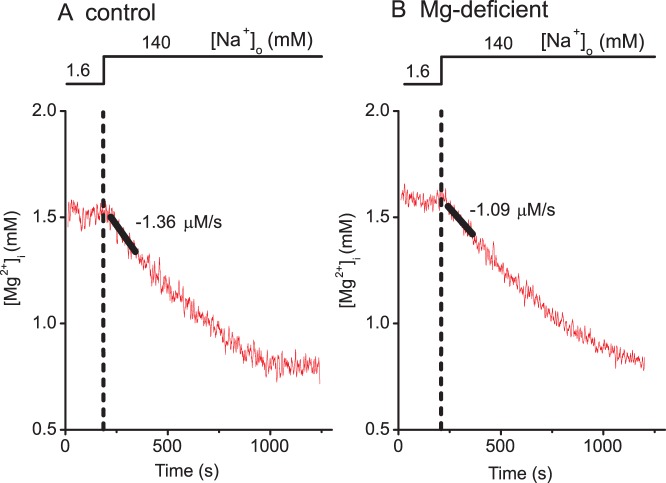
Measurements of extracellular Na+-dependent Mg2+ efflux.Cells isolated from control (A) or Mg-deficient (B) rats were initially incubated in Mg-loading solution that contained 1.6 mM Na+ and 24 mM Mg2+ (Table 1) for 3 h to load the cells with Mg2+. Then Ca2+-free Tyrode’s solution that contained 140 mM Na+ and 1 mM Mg2+ was introduced, as shown at the top. For each data set, a solid line was drawn by the linear least-squares fit to data points between 30 s and 150 s after solution exchange, and the initial rate of change in [Mg2+]i estimated from the slope is indicated near the trace.